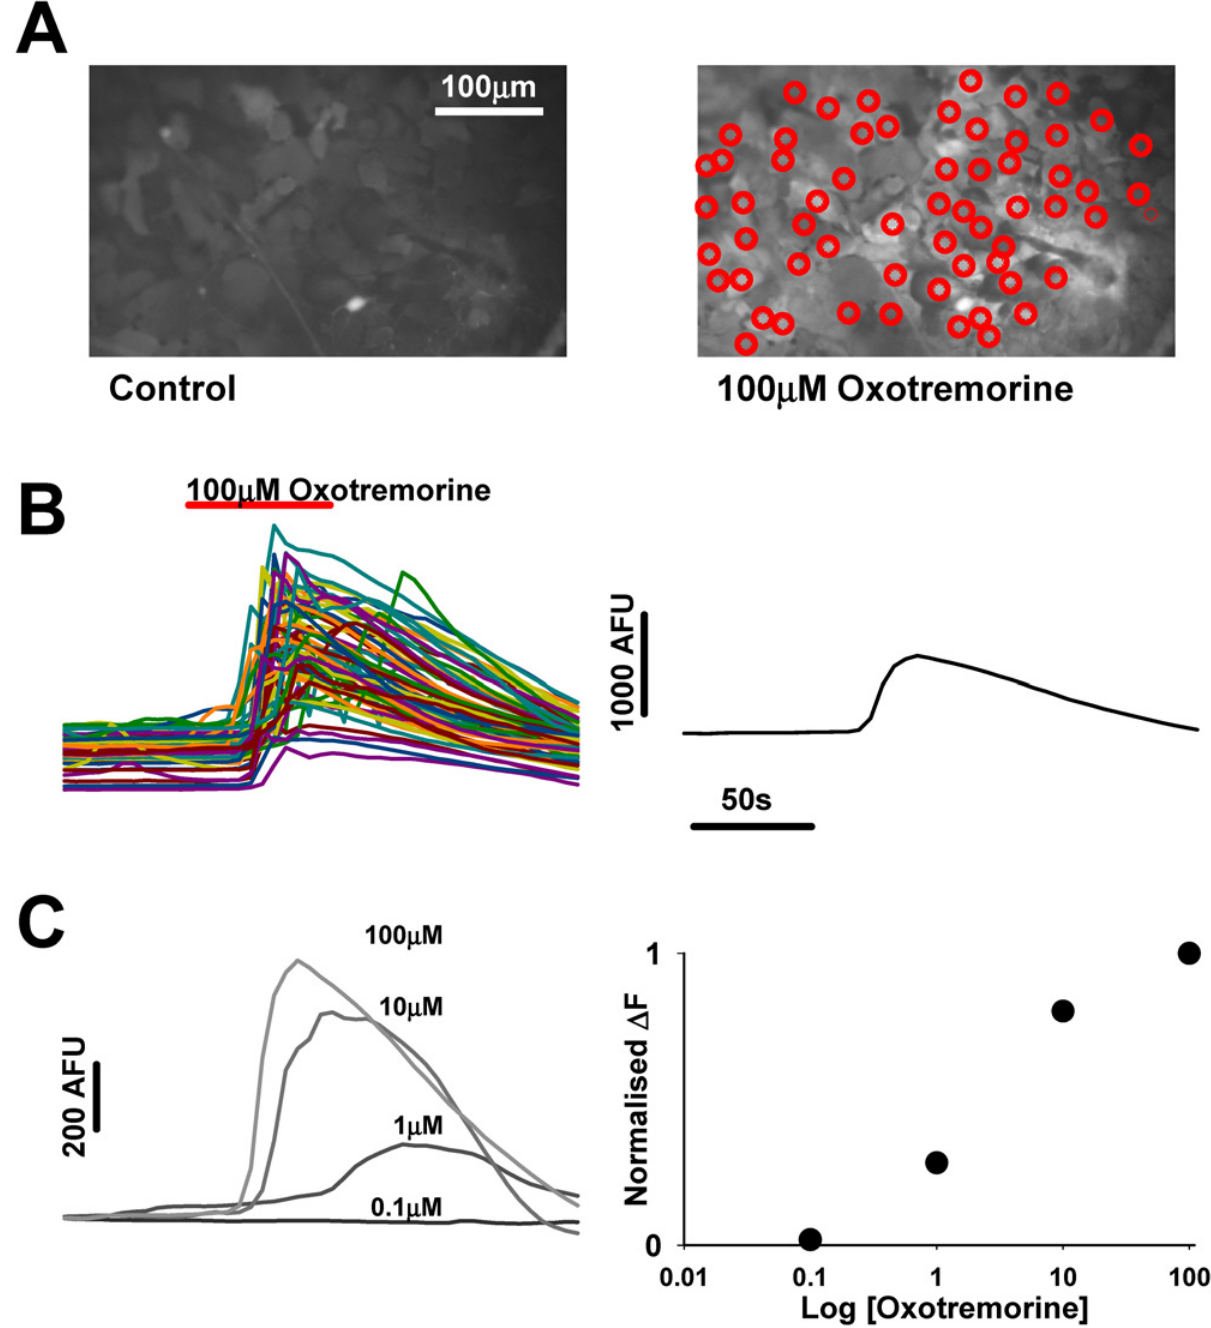
Fig 1. Determination of agonist effect on NT2A cultures. A. Images of field of astrocytes before (left) and during (right) 100 μ M Oxotremorine application. Red circles indicate regions of interest (ROI ’ s) from which fluorescence (AFU-arbitrary fluorescence units) over time are sampled. B. Plot of fluorescence over time showing the effect of oxotremorine on the circled astrocytes in A. Plot on the right displays the average of the astrocyte fluorescence over time. C. Average of fluorescence traces from the same ROI ’ s to 0.1,1,10 and 100 μ M oxotremorine. Plot on the right displays the normalised change in fluorescence from the traces on the right to give the dose response